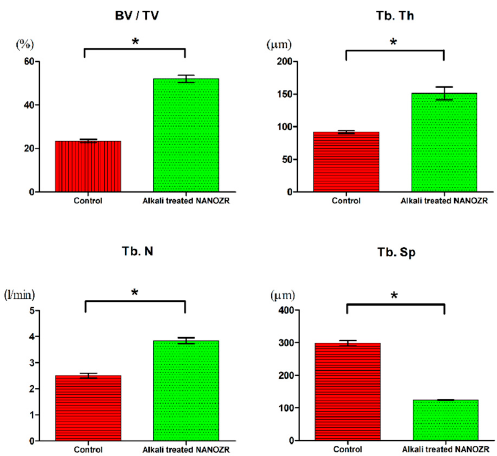
Figure 5. Quantitative evaluation of the trabecular bone within ROI (BV/TV, Tb.N, Tb.Th, and Tb. Sp). * p < 0.05.